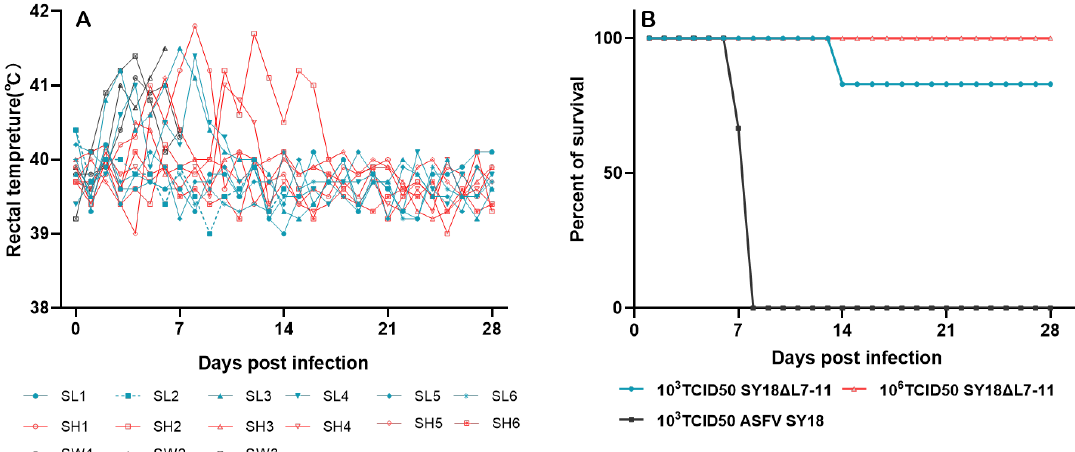
Figure 3. Fever response and survival of swine after inoculation with 10 3 (SL1-SL6) or 10 6 (SH1-SH6) TCID 50 SY18 △ L7-11 and 10 3 TCID 50 ASFV SY18(SW1-SW3). Each curve in figure A represents data from an individual animal. fever response ( A )and survival ( B ).